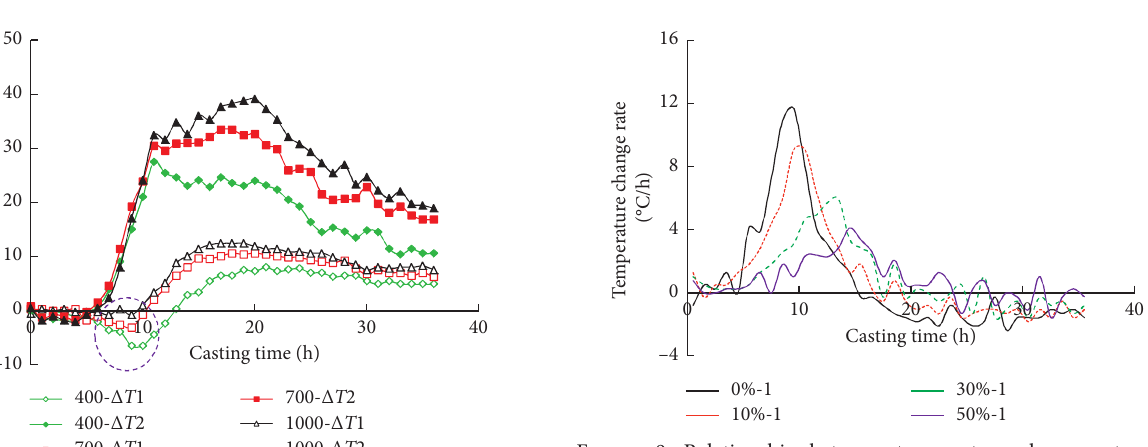
Figure 9: Relationship between temperature change rate and casting time (containing fly ash; #1).